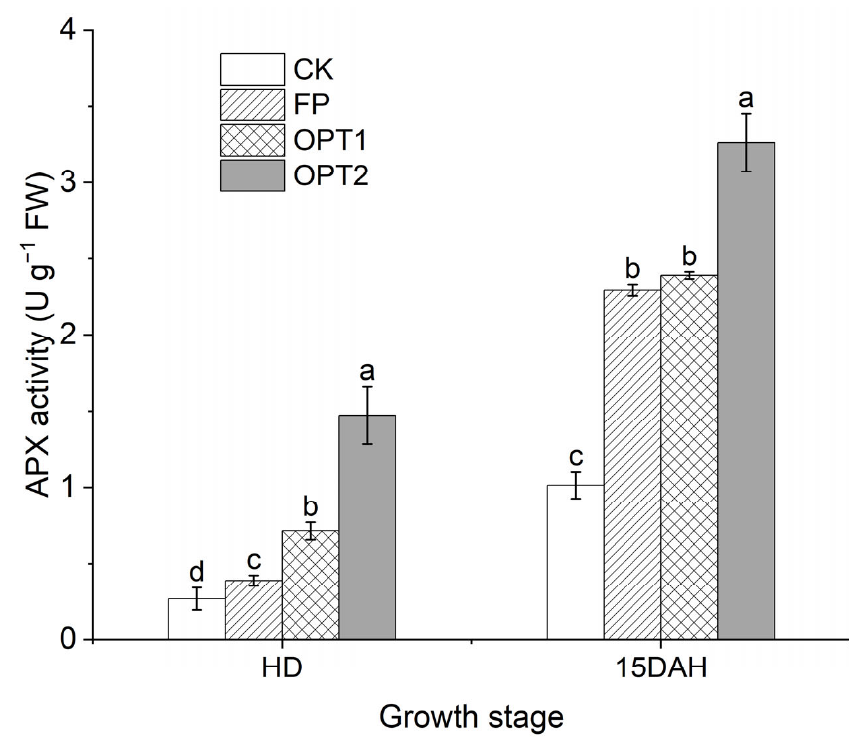
Figure 9. The APX activity under four management systems at HD and 15DAH. Means followed by the same letter do not significantly differ (LSD, p < 0.05).